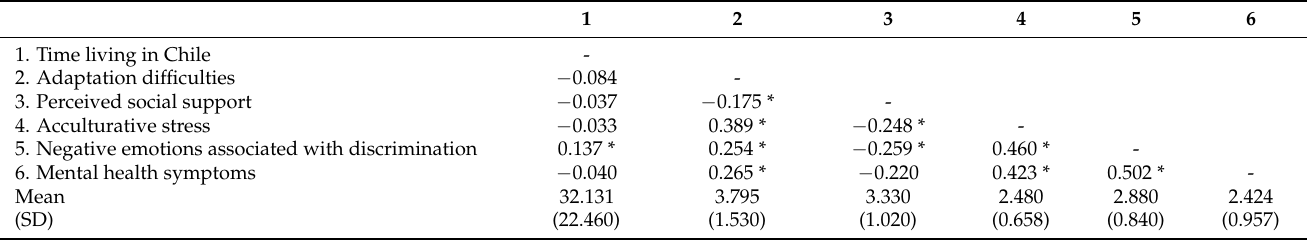
Table 2. Spearman correlations among the study